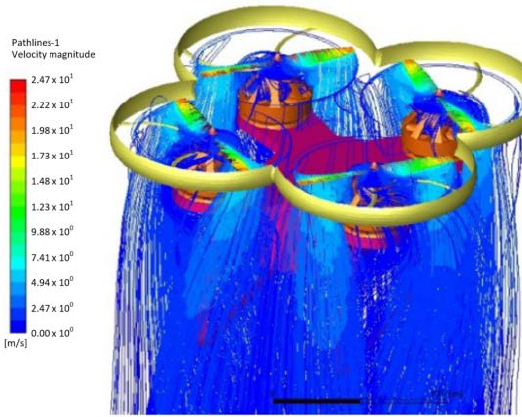
Figure 10. Flight flow field.